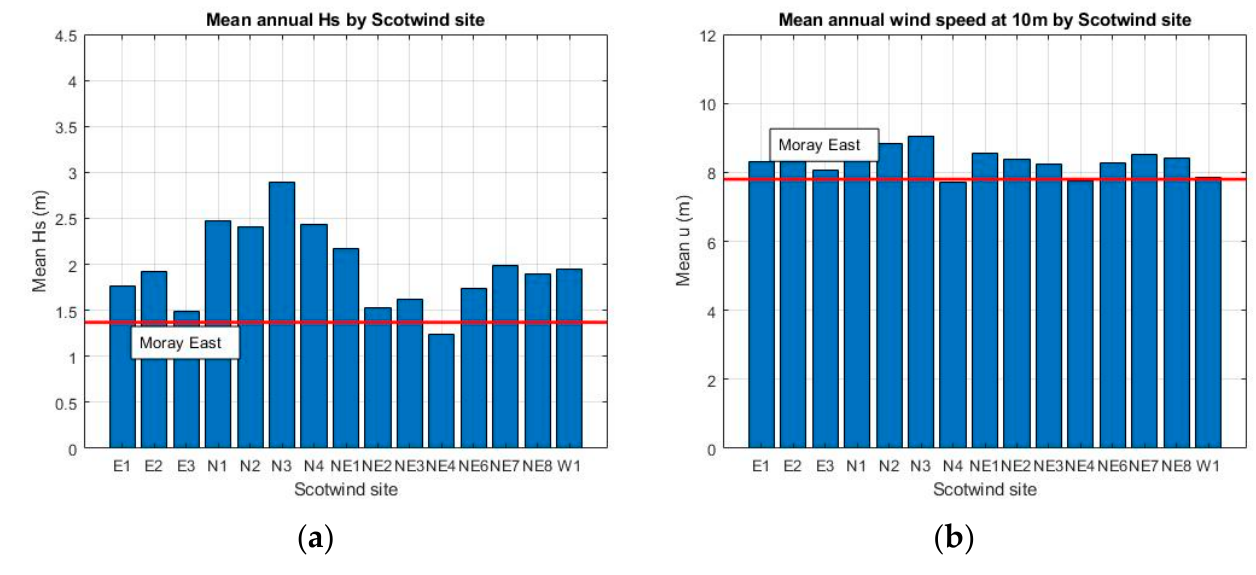
Figure 4. ( a ) Mean annual Hs across Scotwind sites ( b ) Mean annual wind speeds across Scotwind sites.